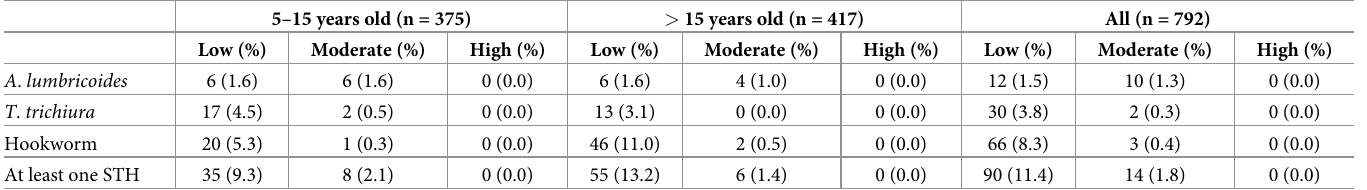
Table 3. Number and percentage of participants with a low, moderate or high intensity of any STH infection detected by single Kato-Katz from one stool; according to WHO. [34].